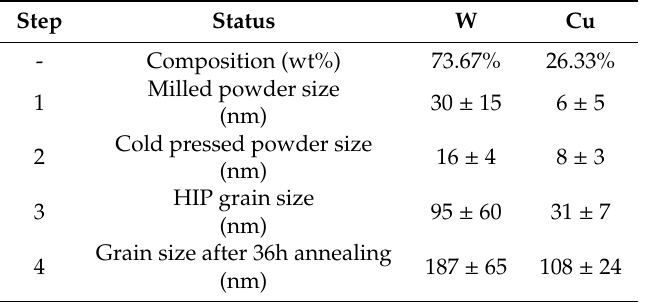
Table 3. XRD results of the W-Cu: milled powder, cold pressed and hot isostatic pressed specimens, average aged (36